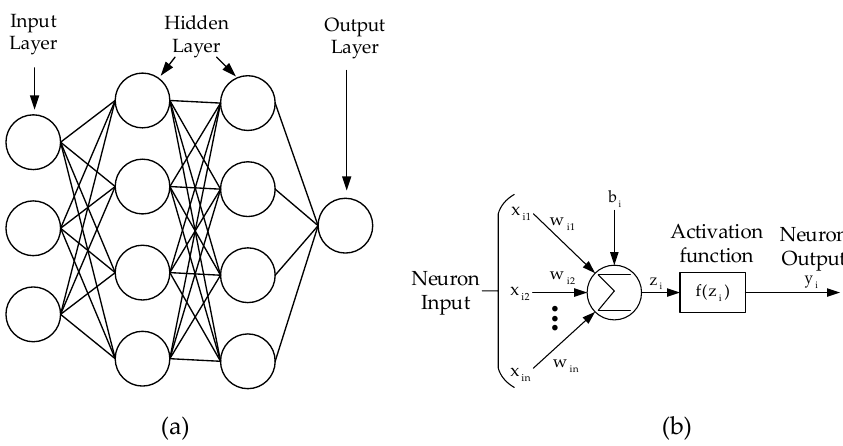
Figure 1. ( a ) A regression neural network and ( b ) the processing role of each neuron. (Adapted from [23]).